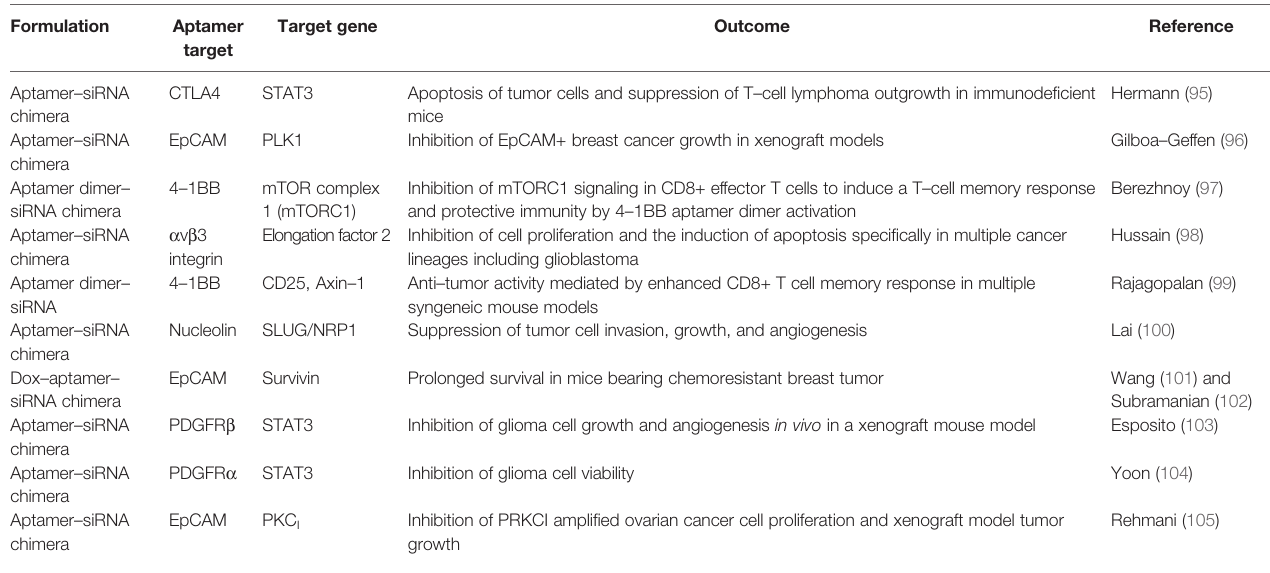
TABLE 1 | Summary of aptamer – siRNA chimeras potentially applicable to the glioblastoma.